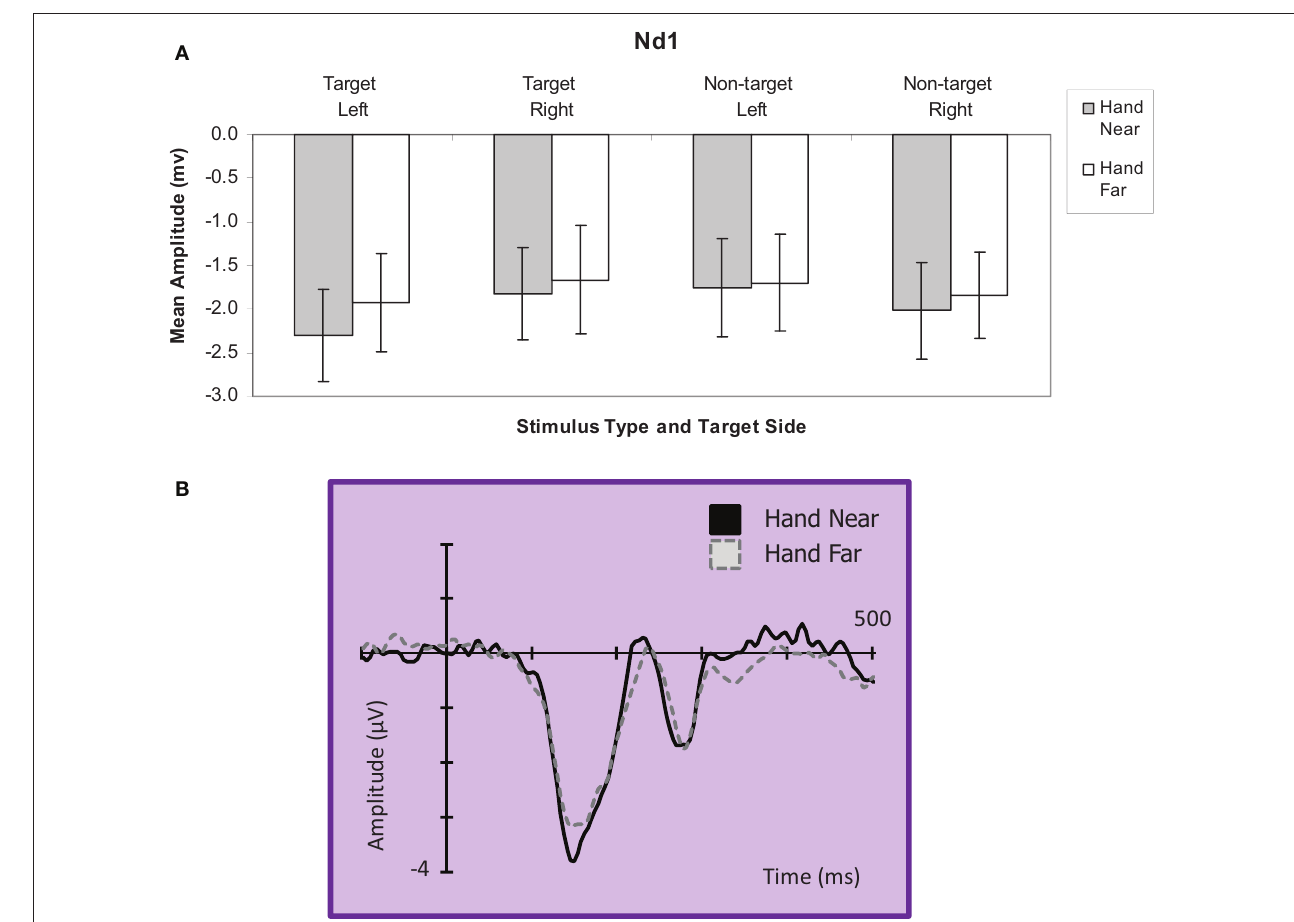
FIGURE 6 | (A) Nd1 (120–190ms) mean amplitudes ( µ V) comparing Hand Near and Hand Far conditions for left and right-side target and non-target stimuli for the central electrode cluster. Error bars represent standard error. (B) Grand average waveform for the Nd1 at